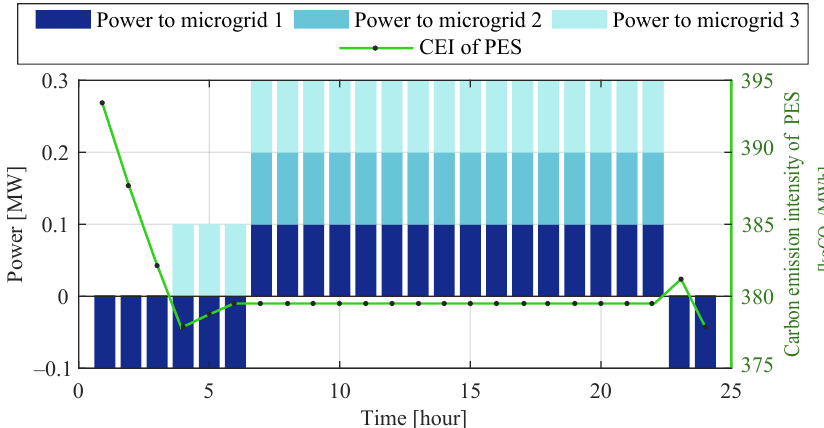
Figure 7. Source of electrical power for PES and CEI of PES.